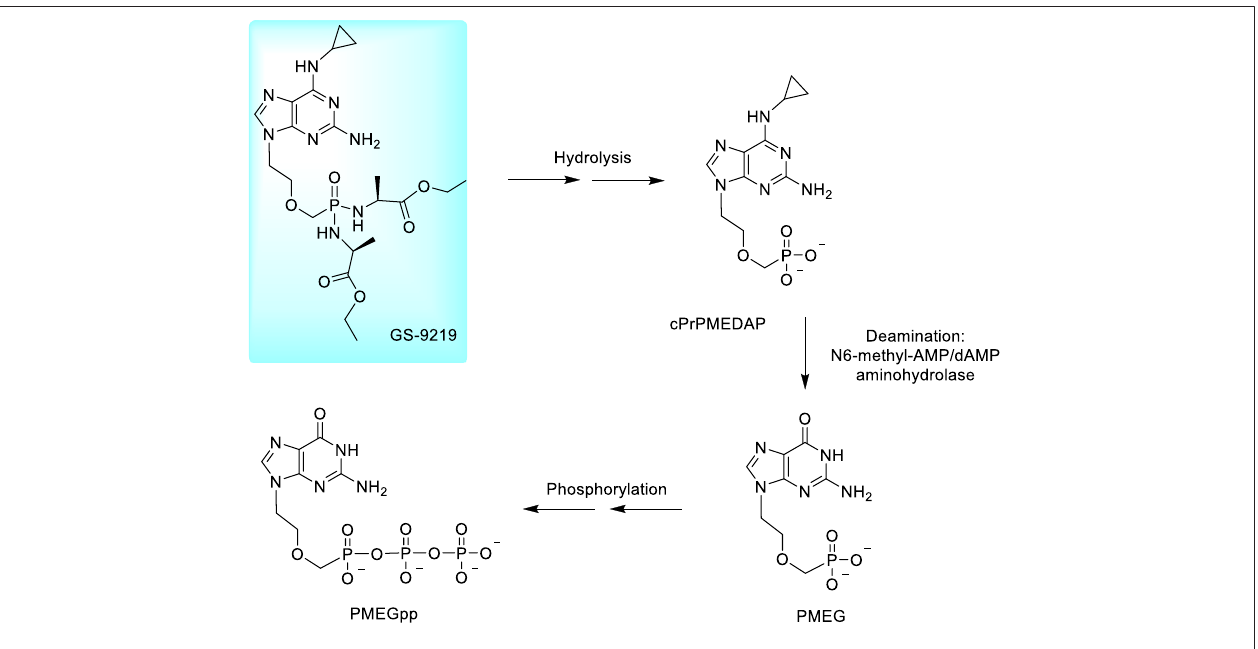
FIGURE 8 | Metabolic conversion of rabacfosadine to PMEG